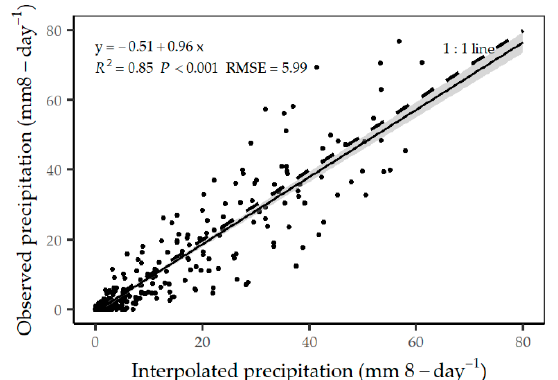
Figure 3. Comparison between the interpolated and observed precipitation data. The linear relationship between the observed and simulated precipitation were given with the coefficients of determination (R 2 ) and the significance level ( p values). The shade of the solid line represented the 95% confidence intervals. The root mean square error (RMSE) and the 1:1 line (dashed ones) were also given to show the standard deviation of the simulated values from the observed ones.